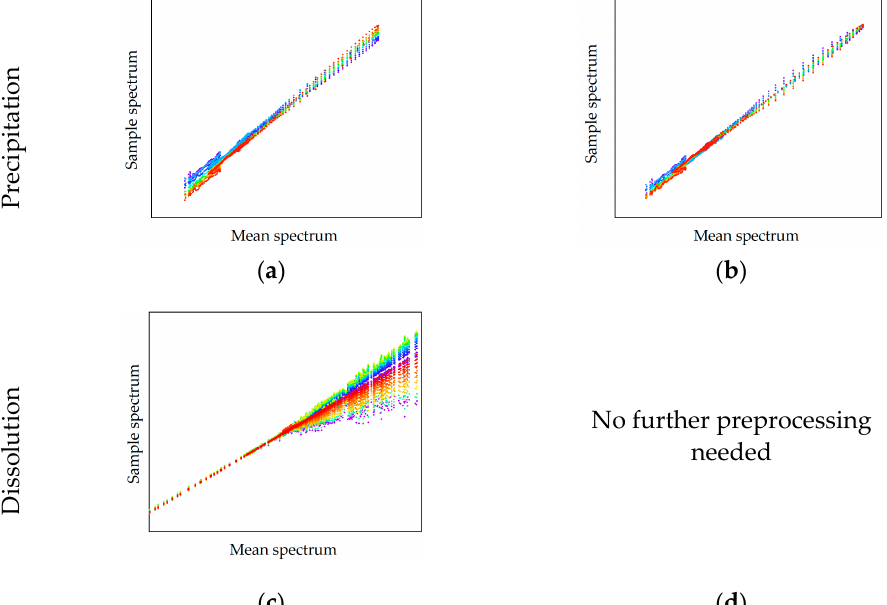
Figure 10. FTIR scatter effects plot for evaluation of needed preprocessing of spectral data. Scatter effects of raw spectral data ( a ) and preprocessed data ( b ) of precipitation are shown as well as the scatter effects of raw data in dissolution ( c ). No further preprocessing was needed for FTIR raw data for dissolution ( d ).